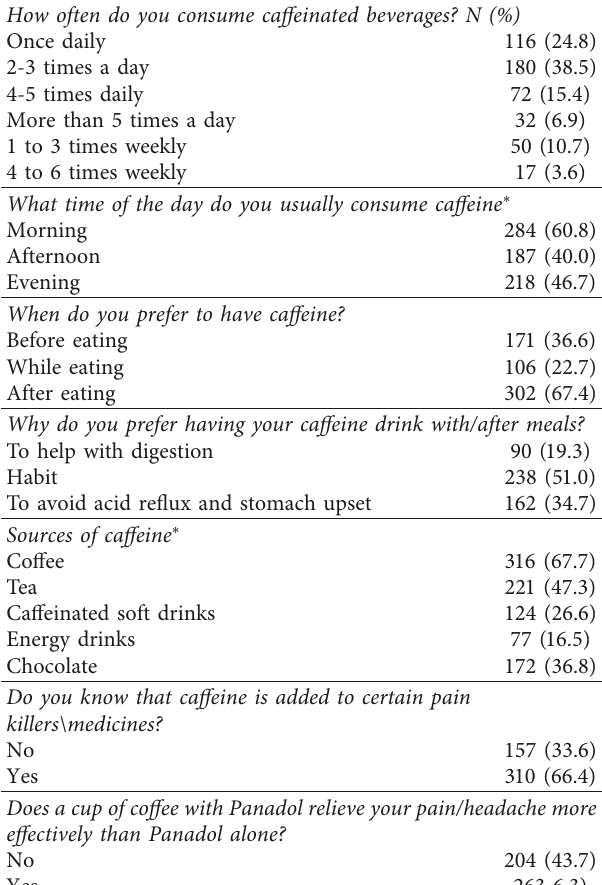
Table 2: Caffeine consumption